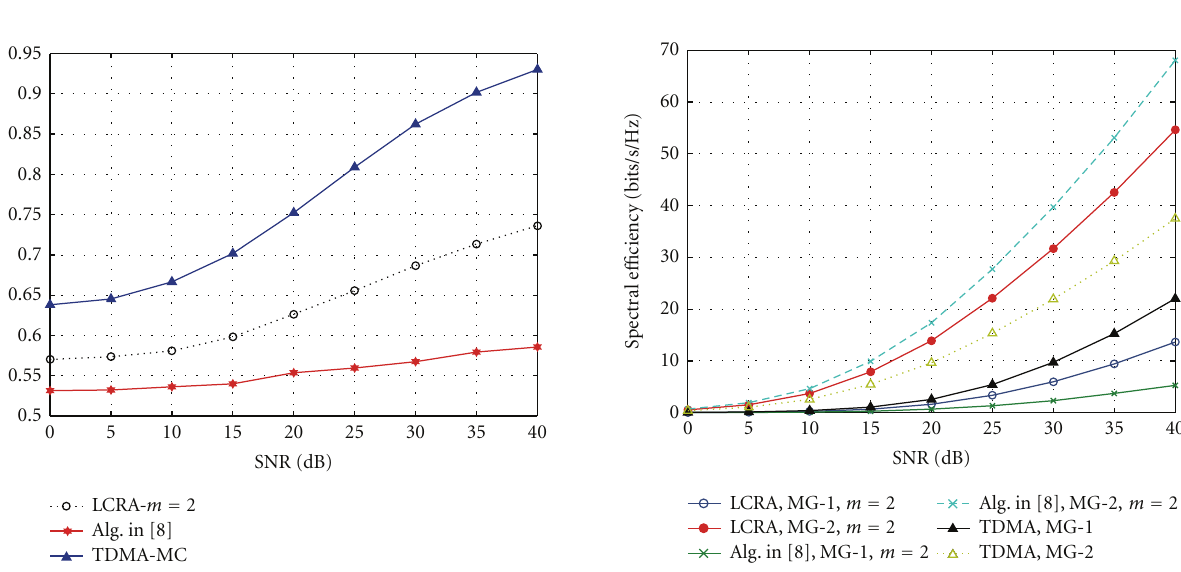
Figure 12: Fairness pointer versus SNR—pathloss di ff erence be- tween MGs.